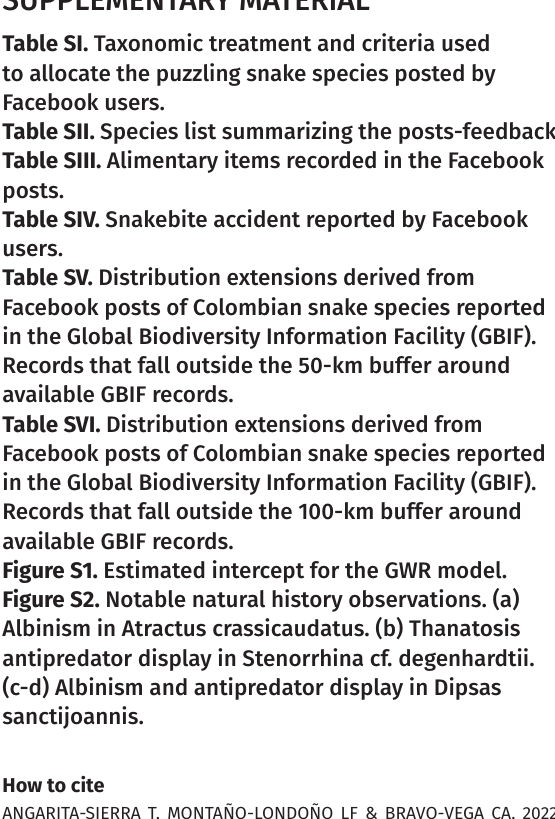
Figure S1. Estimated intercept for the GWR model. Figure S2. Notable natural history observations. (a) Albinism in Atractus crassicaudatus. (b) Thanatosis antipredator display in Stenorrhina cf. degenhardtii. (c-d) Albinism and antipredator display in Dipsas